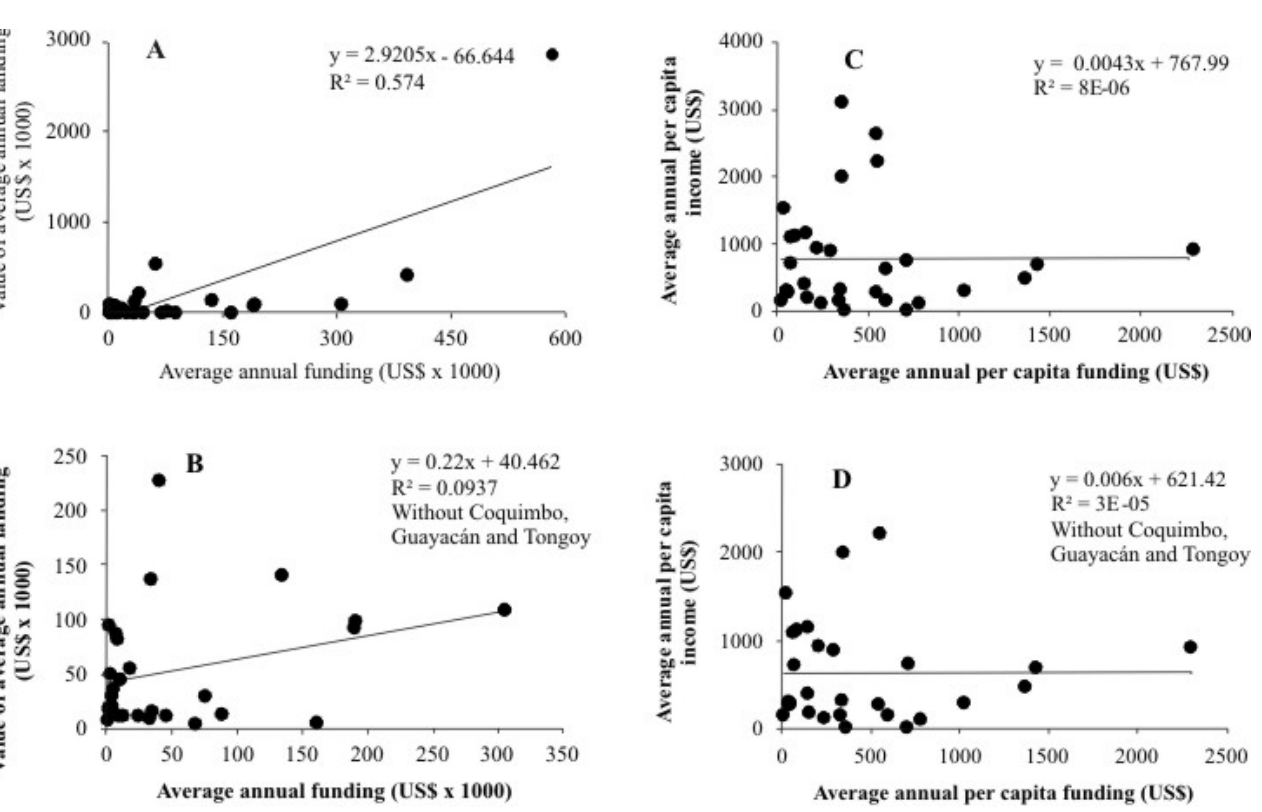
Fig. 5 . Relation between average annual funding and landing (A, B) and per capita income and per capita funding (C, D) of the caletas in the Coquimbo